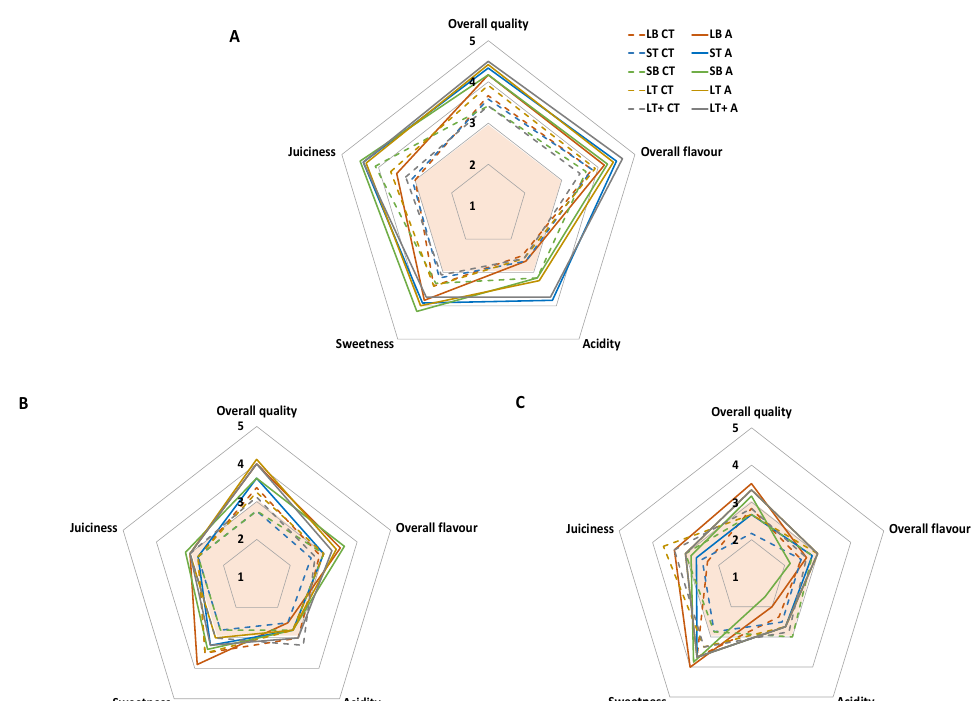
Figure 2. Sensory scores of mandarins packaged within different packages (ST, small tray; SB, small box; LT, large tray; LT+, large tray with alveoli tray; and LB, large box), non-active (CT) and active (A), after cold storage (( A ); 5 days at 8 °C) followed by a commercialization simulation (room temperature) for 2 weeks ( B ) or 3 weeks ( C ). The coloured orange area defines the limit of acceptability (scores below 3 are considered below the limit of acceptability).